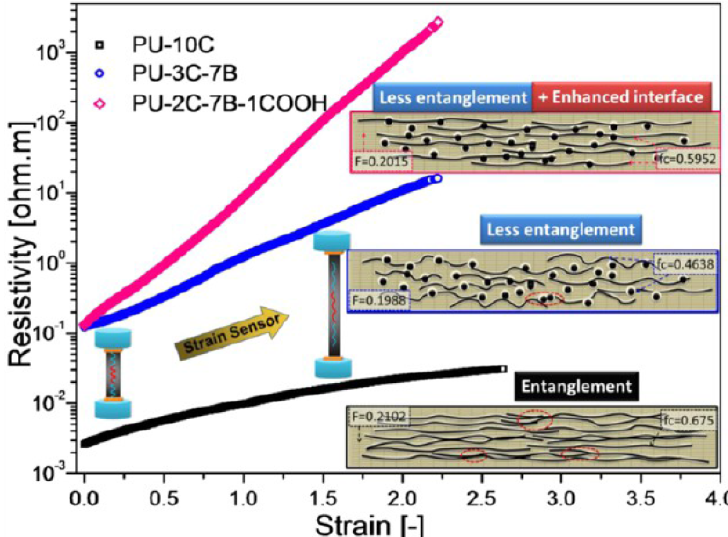
Figure 27. Strain-sensing behavior measurement for TPU/MWNTs/CB composites: TPU with 10 wt% of MWCNT (black curve); TPU with 3 wt% of MWCNT + 7 wt% of CB (blue curve); and TPU with 2 wt% of MWCNT + 7 wt% of CB + 1wt% of acid functionalized MWCNT (pink curve). In the inset, a possible mechanism which explains the reasons of the enhanced strain sensitivity of the composite. Copyright (2014) Royal Society of